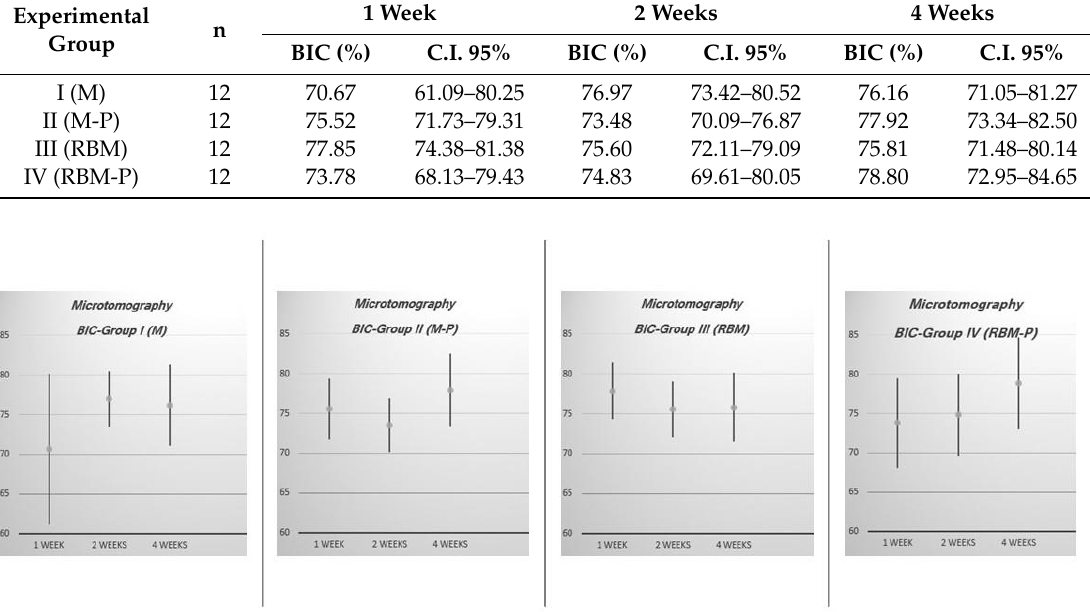
Table 1. BIC percentages and standard deviation of each experimental group obtained by microtomography at 1, 2, and 4 weeks. No statistically significant difference was observed between groups or between time intervals taking into account the significance value of p < 0.05.